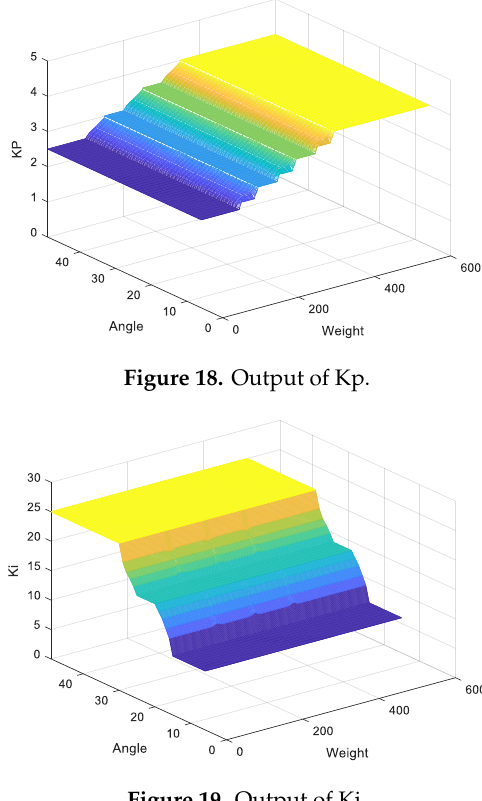
Figure 19. Output of Ki.